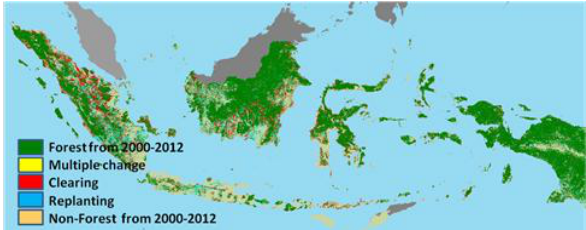
Figure 6. Total forest loss and gain 2000-2012 at national